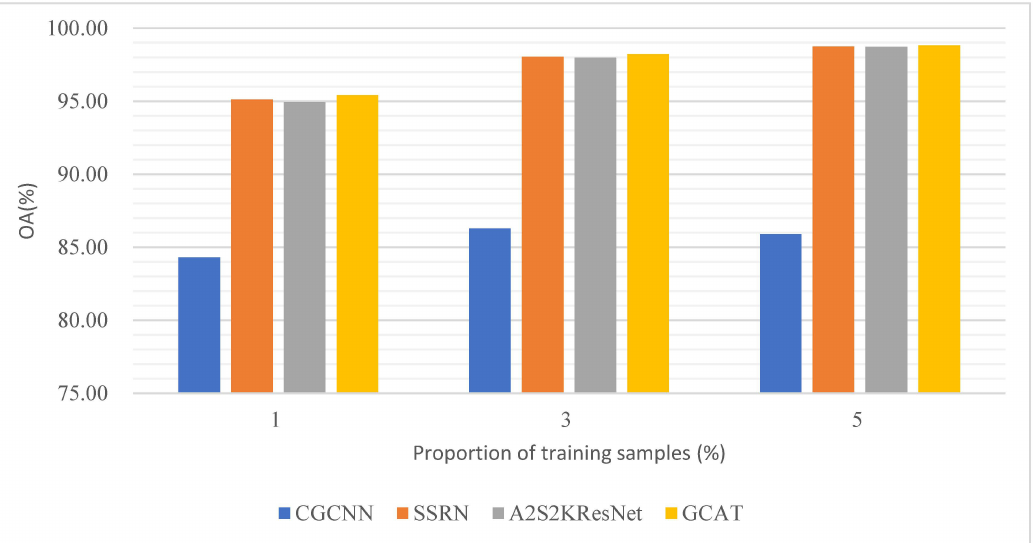
Figure 6. Classification results on the oil type data with different proportions of training samples.